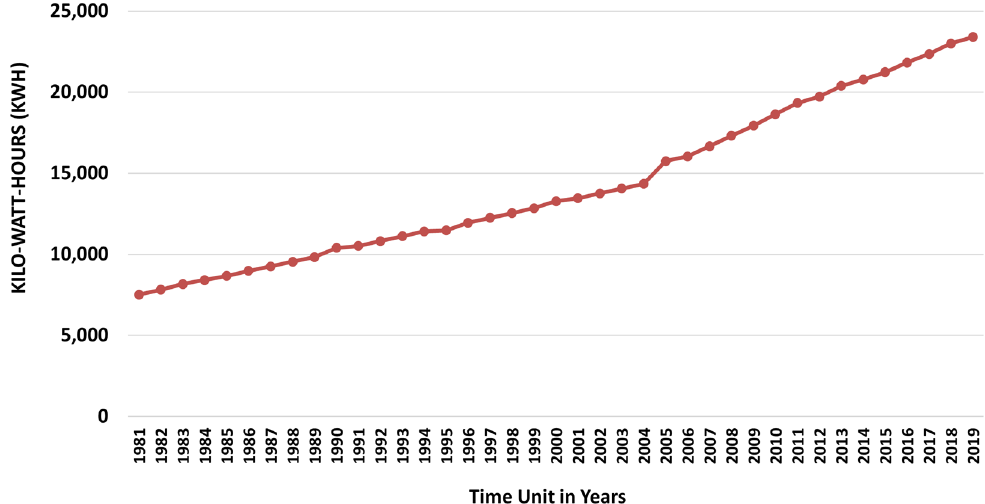
Figure 1. The overall growth in net consumption of electricity worldwide from 1980 to 2019 (in billion kilowatt-hours).